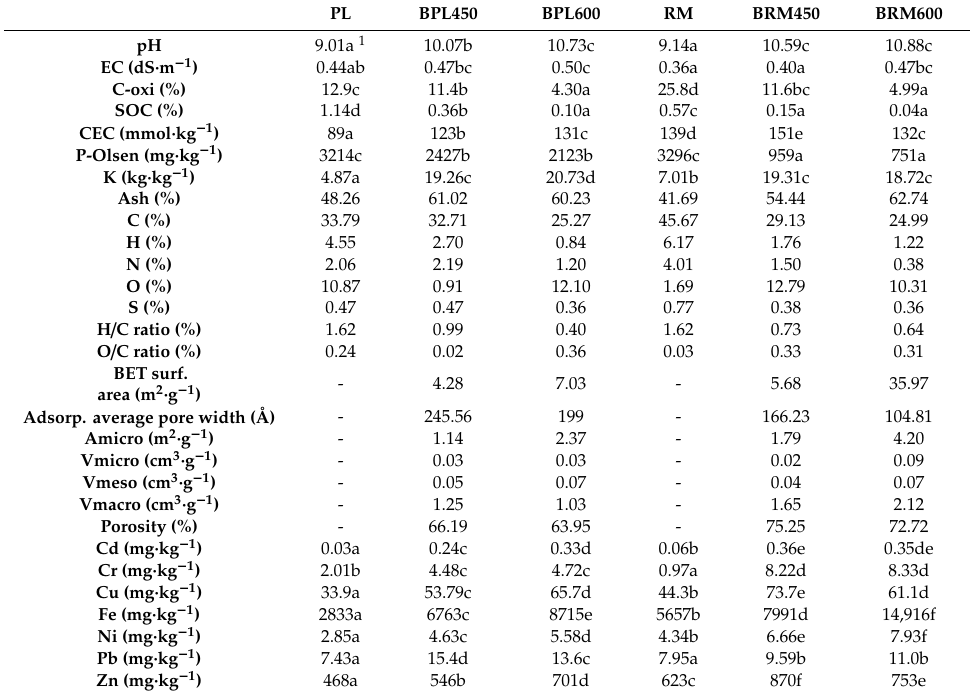
Table 1. Main properties of manure wastes and